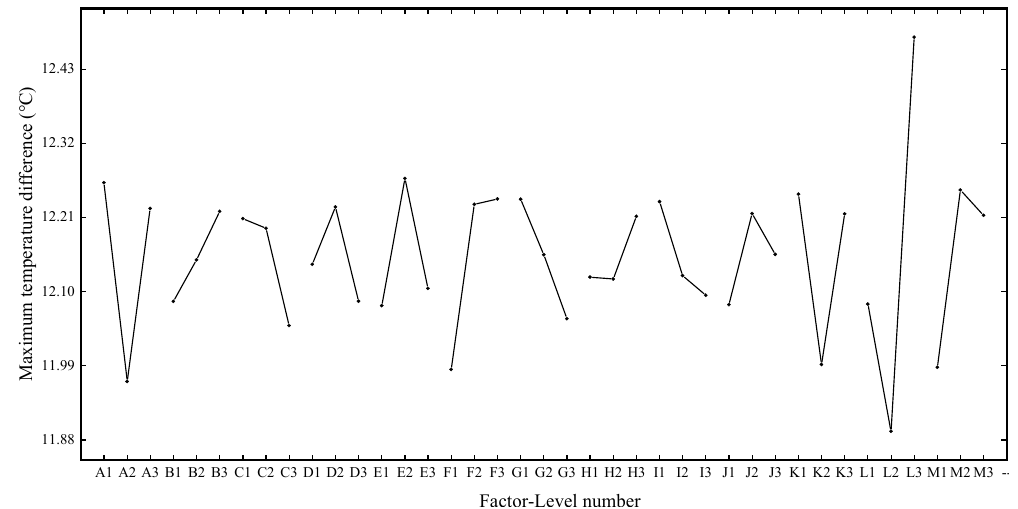
Figure 9. Maximum temperature difference effect curve.